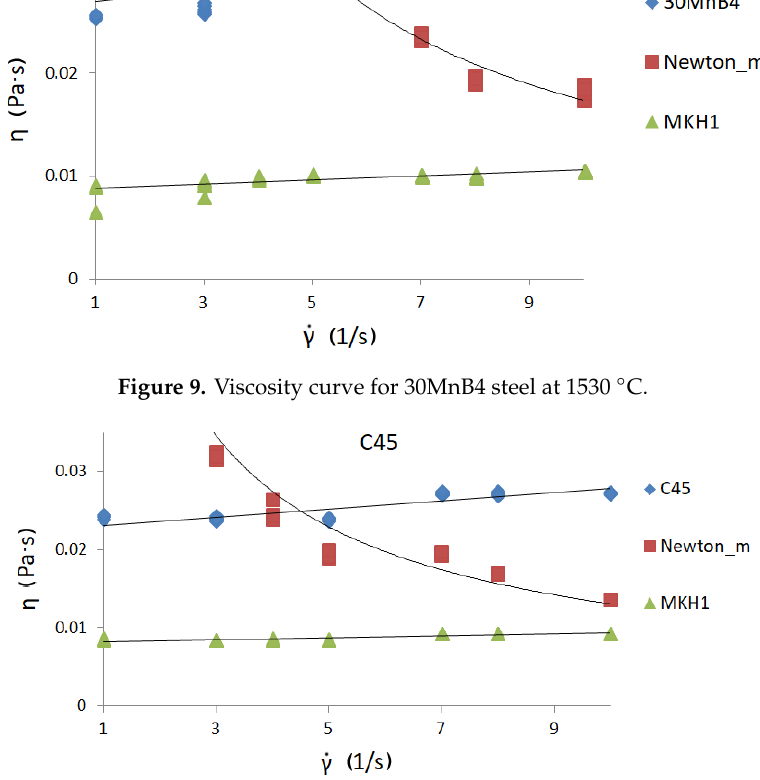
Figure 10. Viscosity curve for C45 steel at 1530 °C.